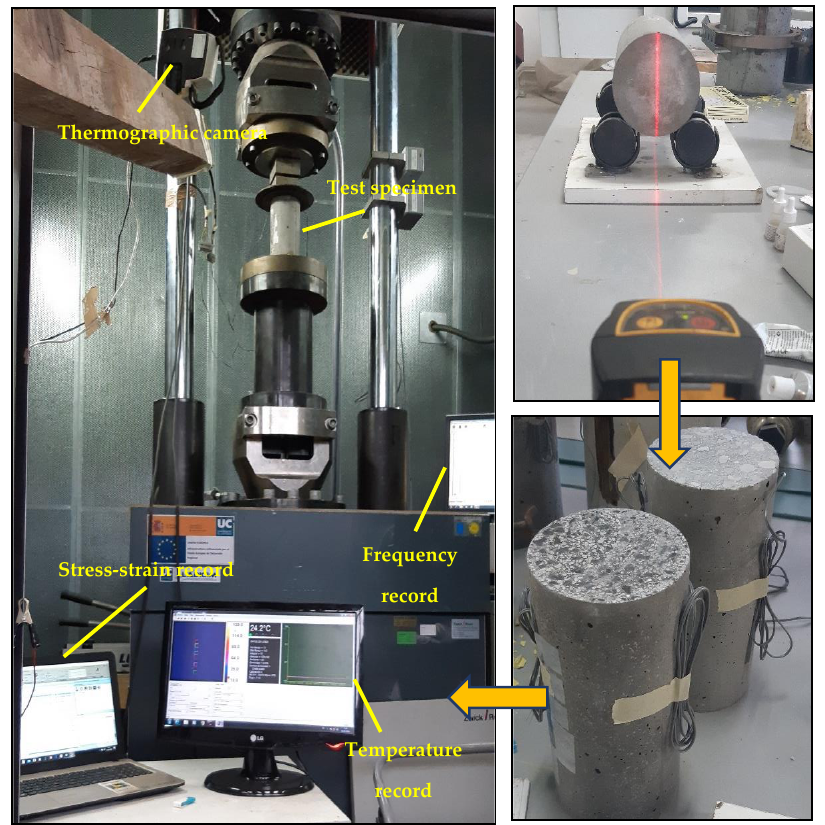
Figure 3. Preparation of the specimens and experimental setup used.